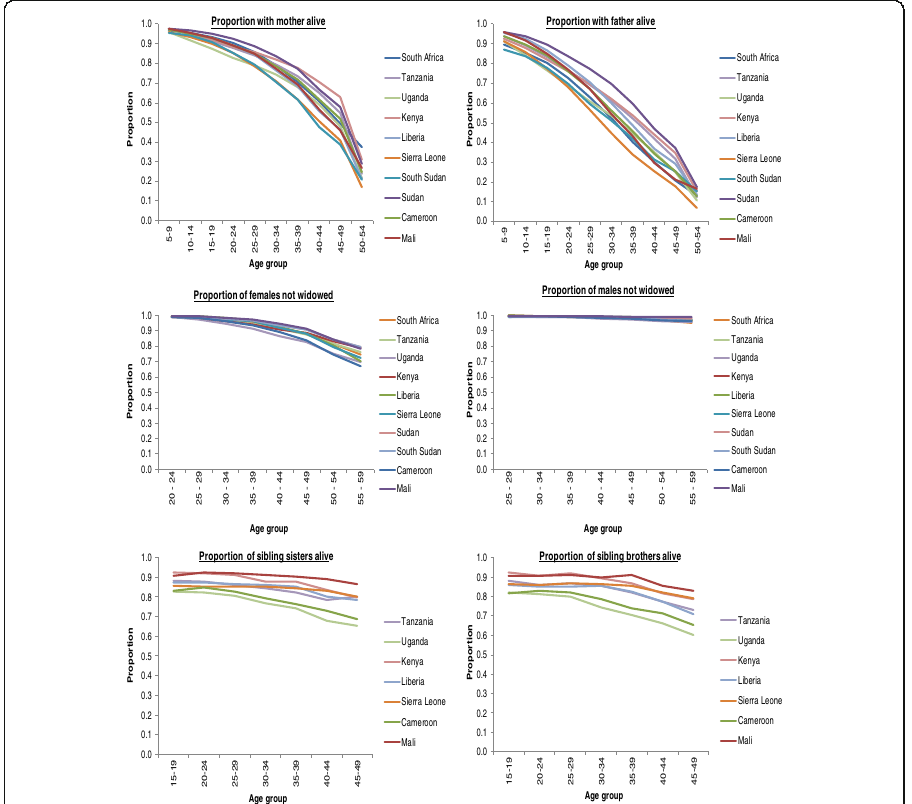
Fig. 1 Proportions of fathers/mothers alive, spouses not widowed, and brothers/sisters alive